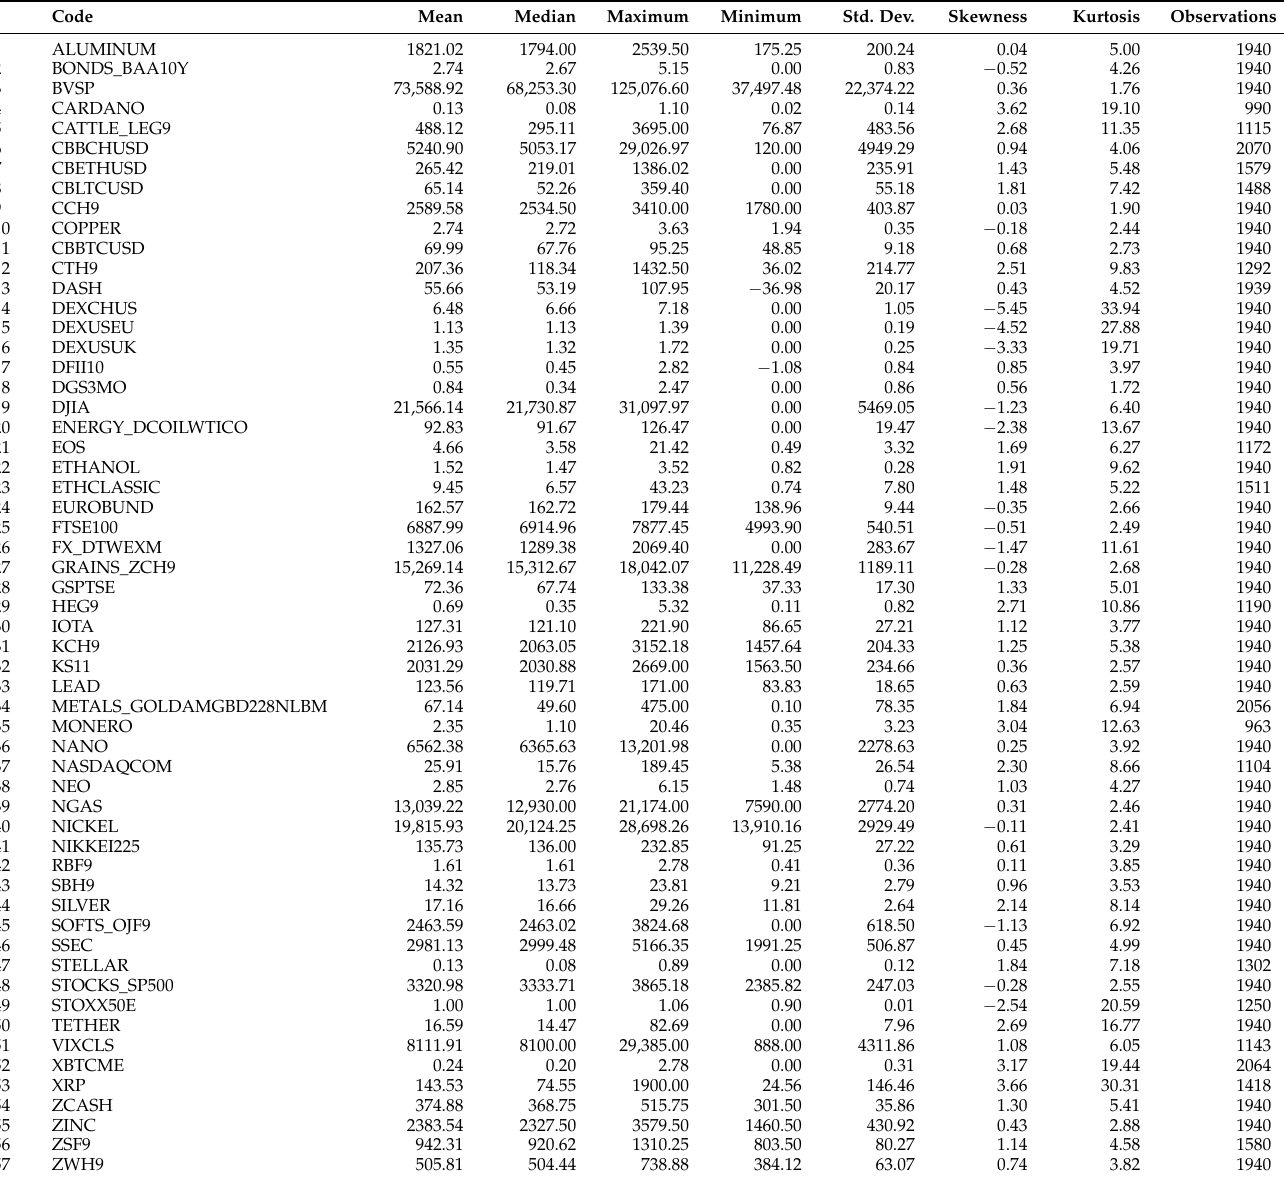
Table 2. Descriptive statistics of the raw